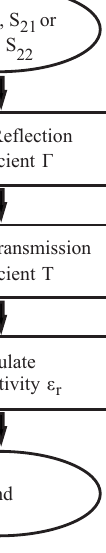
Figure 9. Flow chart of the NRW